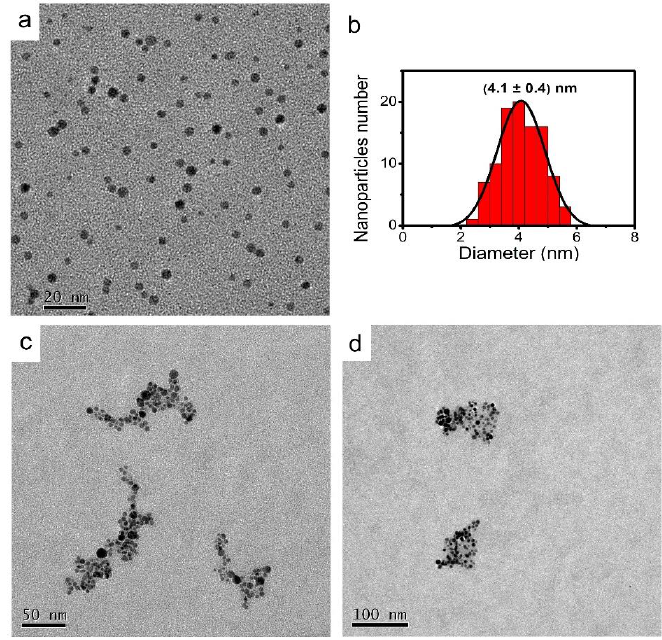
Figure 3. TEM image of AgNPs-3MPS ( a ); histogram of the average dimensions of the nanoparticles obtained by the analysis of 100 particles ( b ); scale bars are reported in the lower part of the pictures. TEM image of AgNPs-3MPS with 1.0 ppm of Ni 2+ ( c ); and TEM image of AgNPs-3MPS with 1.0 ppm of Co 2+ ( d ).